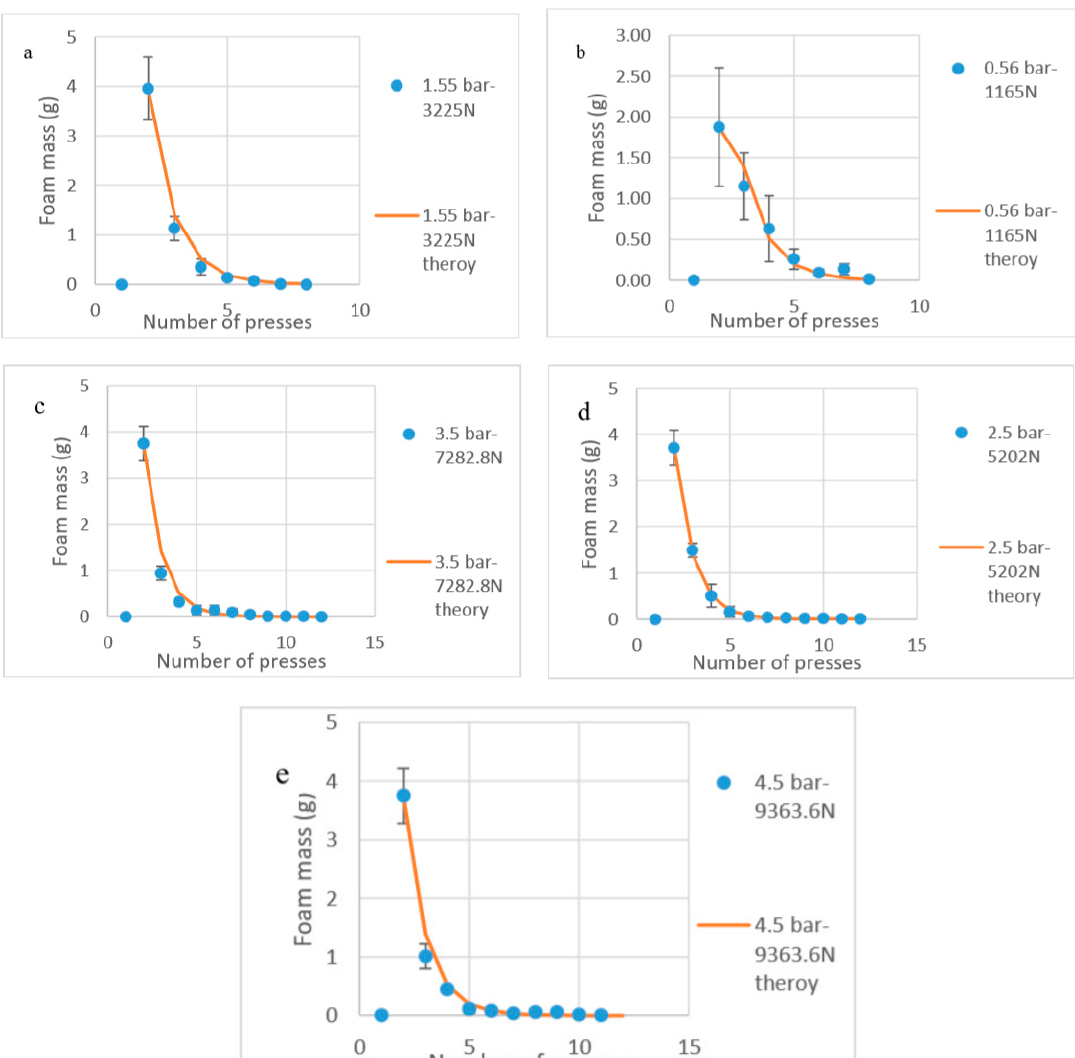
Figure 5. Foam mass for each compression of a dishwasher sponge saturated with 20% commercial dishwashing solution with different compression forces where ( a ) 0.56 bar = 1165 N, α = 2.5 ( b ) 1.55 bar = 3225 N, α = 1.333 ( c ) 2.5 bar = 5202 N, α = 5 ( d ) 3.5 bar = 7282.8 N, α = 10 ( e ) 4.5 bar = 9363.6 N. The Theoretical values are calculated using Equation (20).